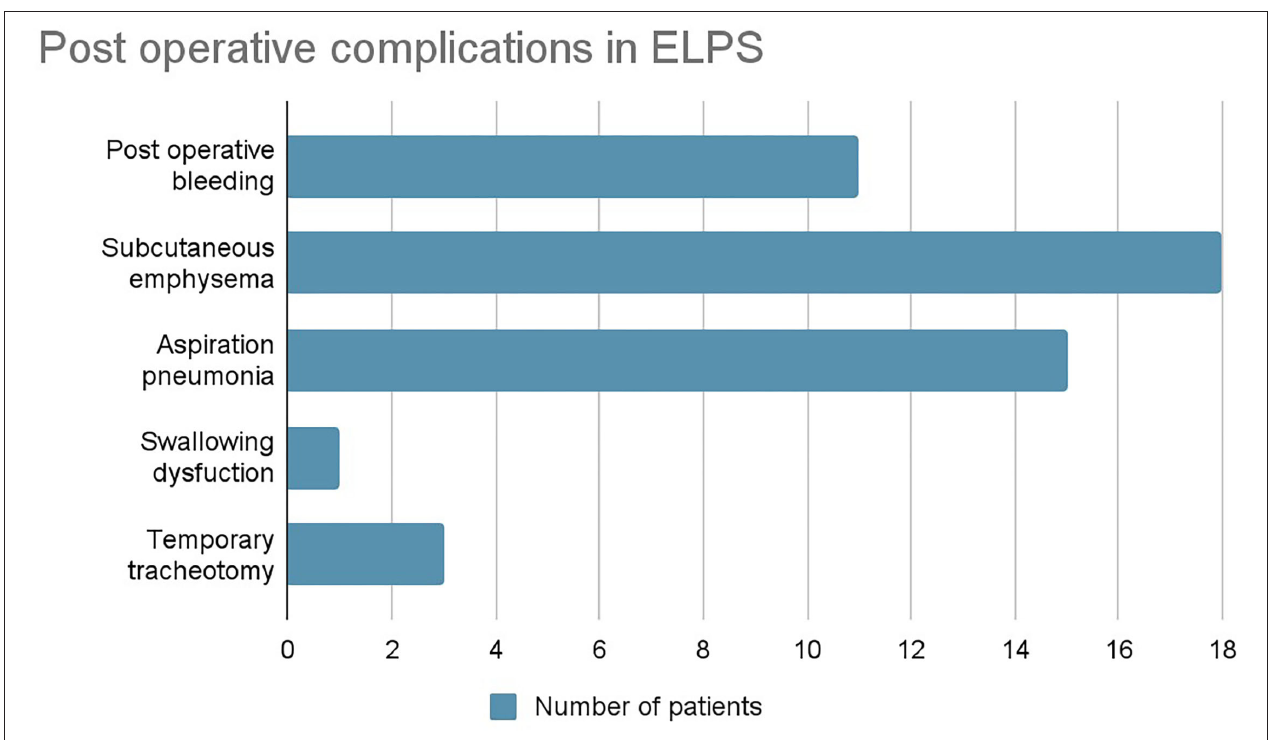
FIGURE 6 | Post-operative complications in ELPS.